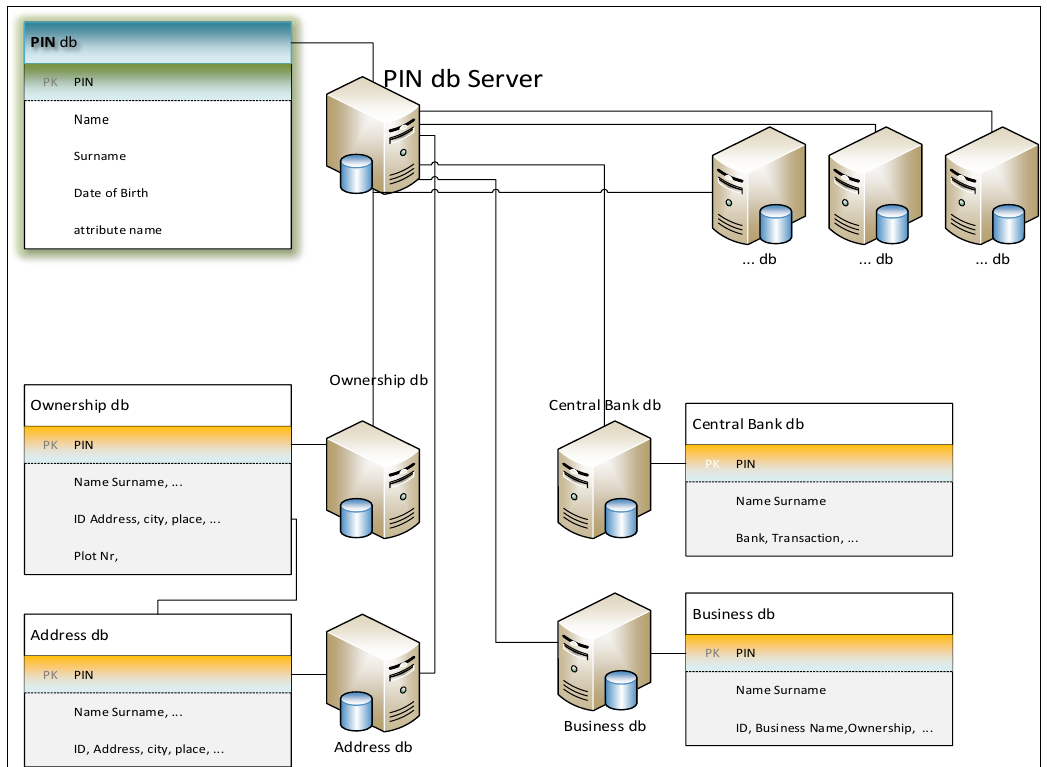
Figure 1. Example of linking other databases to personal